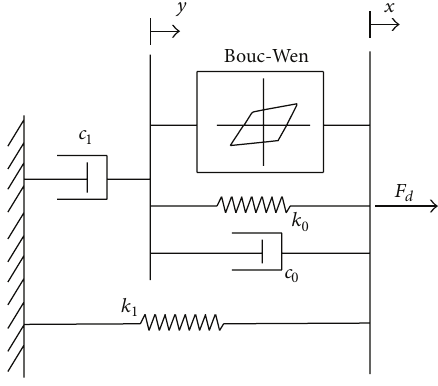
Figure 2: Bouc-Wen mechanical model.